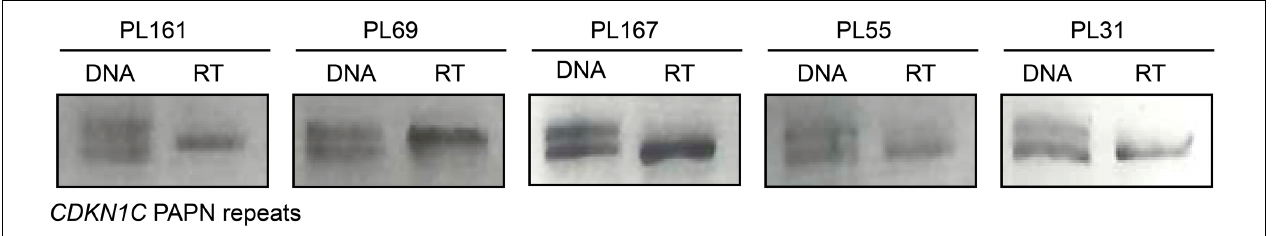
FIGURE 3 | Allele specific expression of the CDKN1C gene in placenta biopsies. The first lane for each sample represents amplification of the PAPA repeat in genomic DNA. PCR products were visualized on 4% agarose gels and alleles discriminated based on amplicon size. Only heterozygous genotypes were selected for allelic expression analysis. The second lane is amplification from cDNA following reverse transcription showing monoallelic expression.